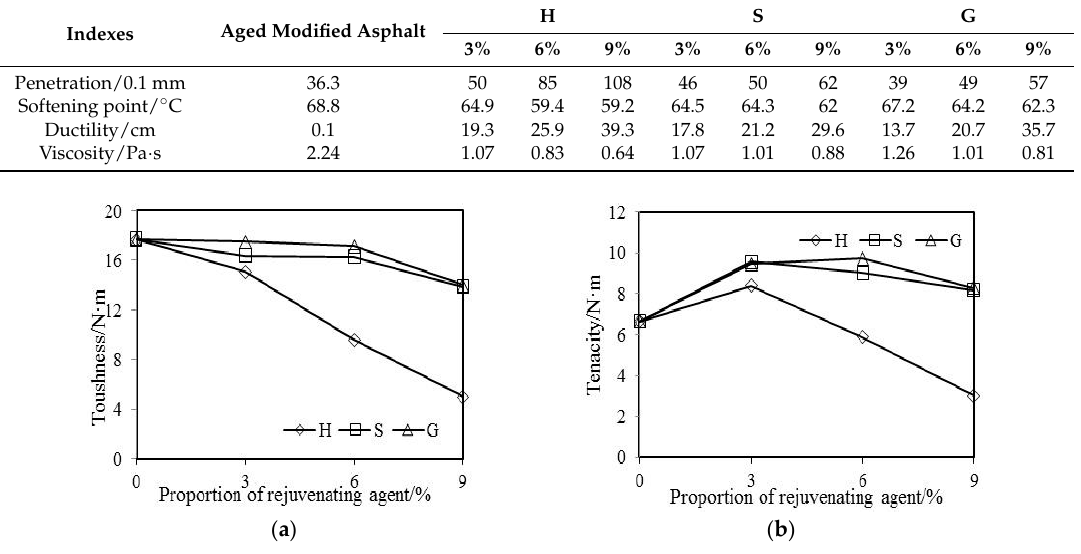
Figure 3. Relationship between ( a ) toughness, ( b ) tenacity and proportion of Rejuvenating Agent.